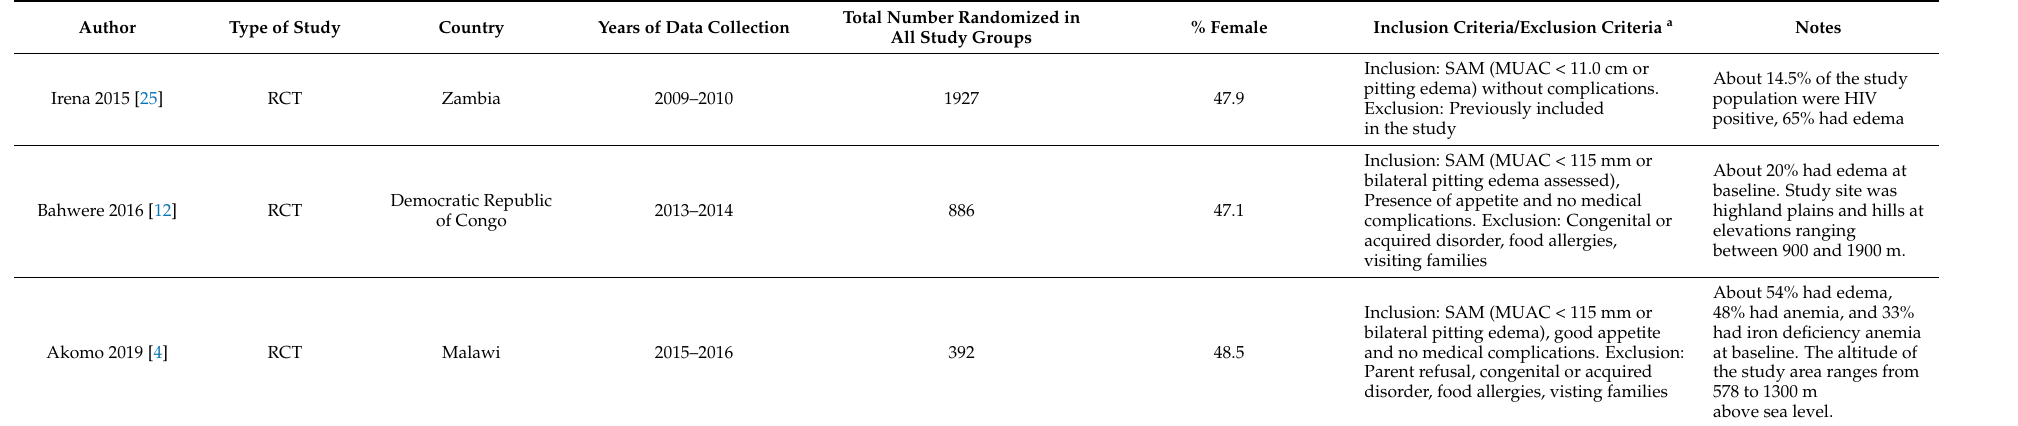
Table 1. Participant characteristics in the included studies.